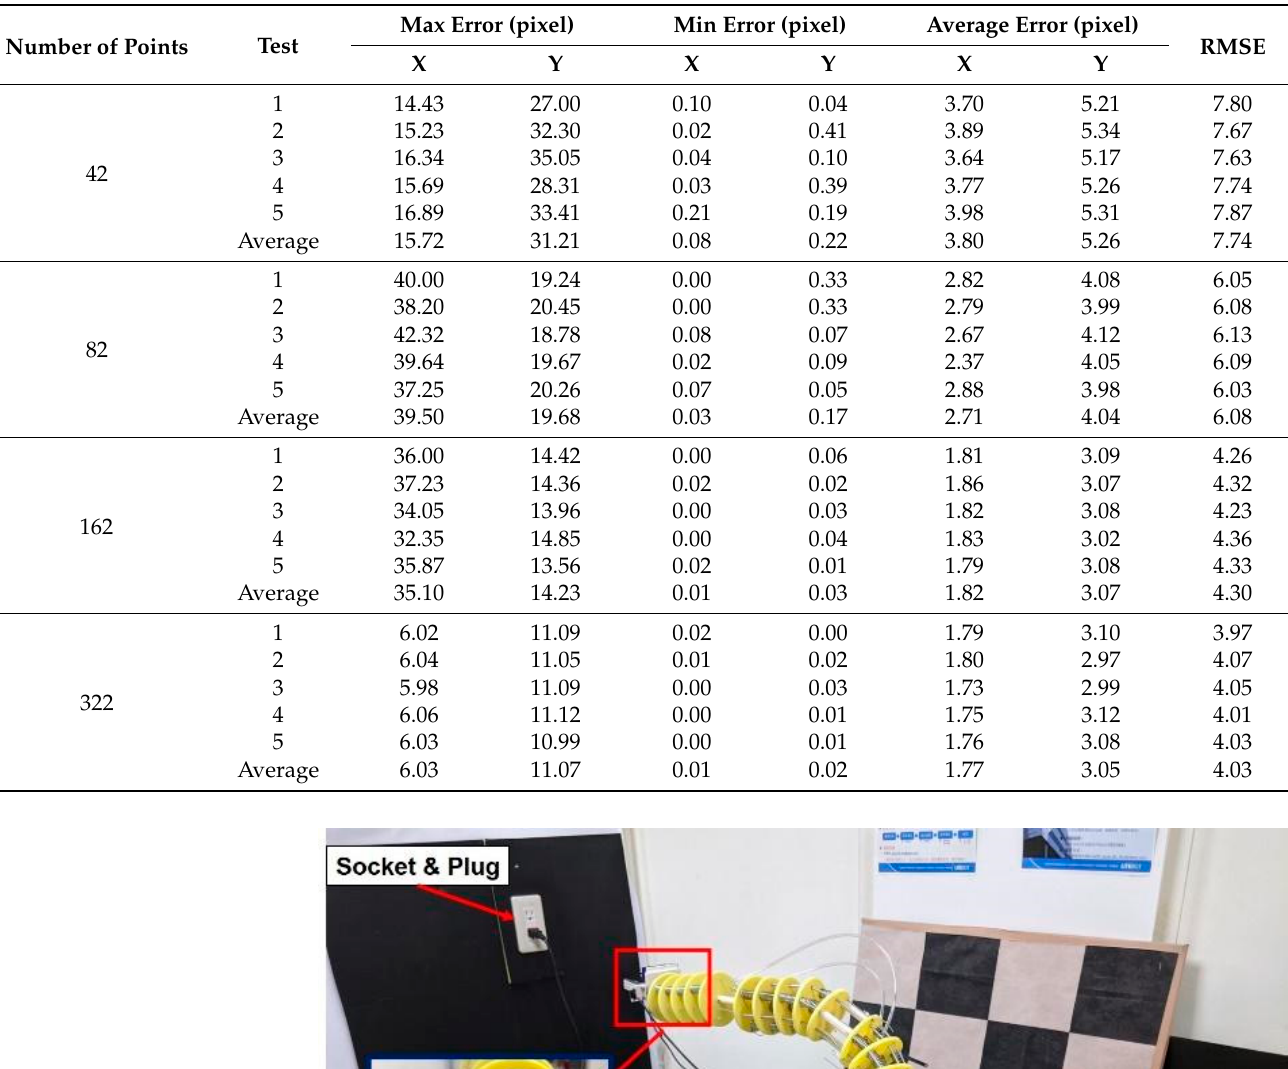
Table 4. Velocity kinematics simulations-Endpoint error of the manipulator posture.